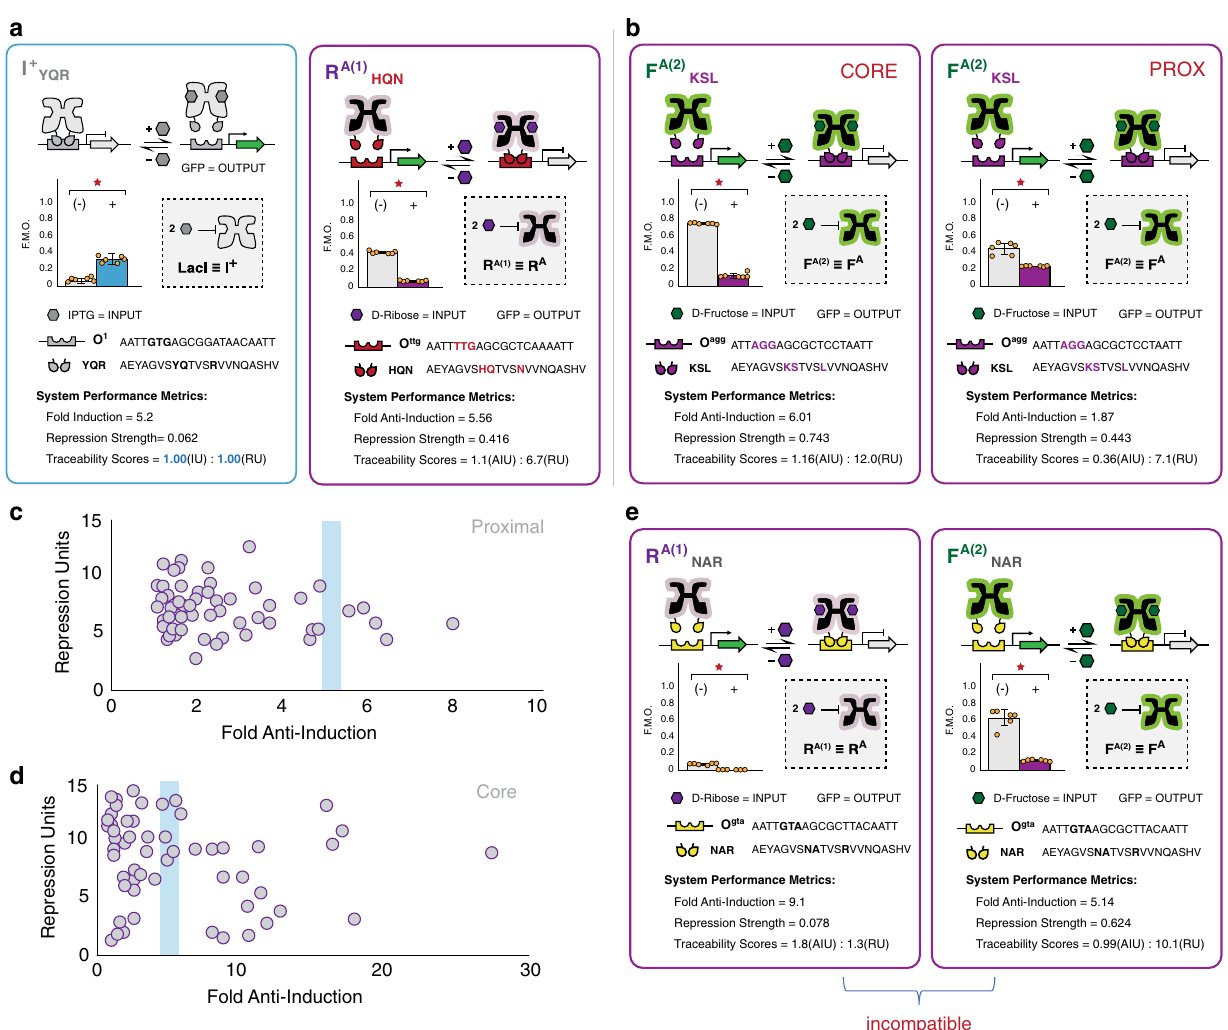
Fig. 5 Metrology for engineered anti-repressors. Performance cards can be generated for biological unit operations (BUO), consisting of a regulatory core, DNA-binding domain paired with an operator, at a given position (core or proximal). Vertical-bars display normalized fl uorescence intensity with the mean de fi ning the measure of centre (±1 S.D.), standardized to the maximum fl uorescence output observed (75,000 r.f.u.), giving fraction of maximum output, F. M.O. Left-bars show values without ligand, whereas the right is value in the presence of ligand. Red stars signify statistical signi fi cance ( α = 0.001) in a Student ’ s two-tailed t -test for n = 6 independent biological replicates with similar results, dots shown for each replicate. Performance metrics can be calculated, see Supplementary Note 4. a Criteria for robust synthetic biology tools. Left shows the card for the I + YQR | O 1 (proximal) BUO, the reference for metrology (traceability scores of 1.0 for induction units, IU, and repression units, RU). Right shows the R A(1) HQN | O ttg (proximal) BUO, with performance metrics comparable to the reference, indicating the BUO is an acceptable tool for gene regulation in circuits. The I + YQR | O 1 (proximal) BUO is widely- regarded as a standard synthetic biology tool. b The effect of operator position on BUO performance. Performance cards for F A(2) KSL | O agg in the core (left) and proximal (right) positions. With the operator in the core position, the transcription factor performed better compared to the proximal in terms of dynamic range and repression strength (expression in the ON-state). c , d Correlation analyses of anti-repressors generated in this work: c proximal and d core operator positions. Left axis shows repression units and bottom axis, the fold anti-induction (fold change). Each dot represents a BUO engineered in this work. Blue rectangles indicate the fold change of the reference BUO. e Incompatible pairing of BUO. Left, R A(1) NAR | O gta(core) , with anti-induction and repression units in proximity, and right , F A(2) NAR | O gta(core) performance cards. Disparities in performance metrics, namely fold anti-induction and repression strength, cause these BUO to be incompatible when paired in proposed combinatorial logical operations. R A(1) NAR would nullify the performance of F A(2) NAR when used together in a gene